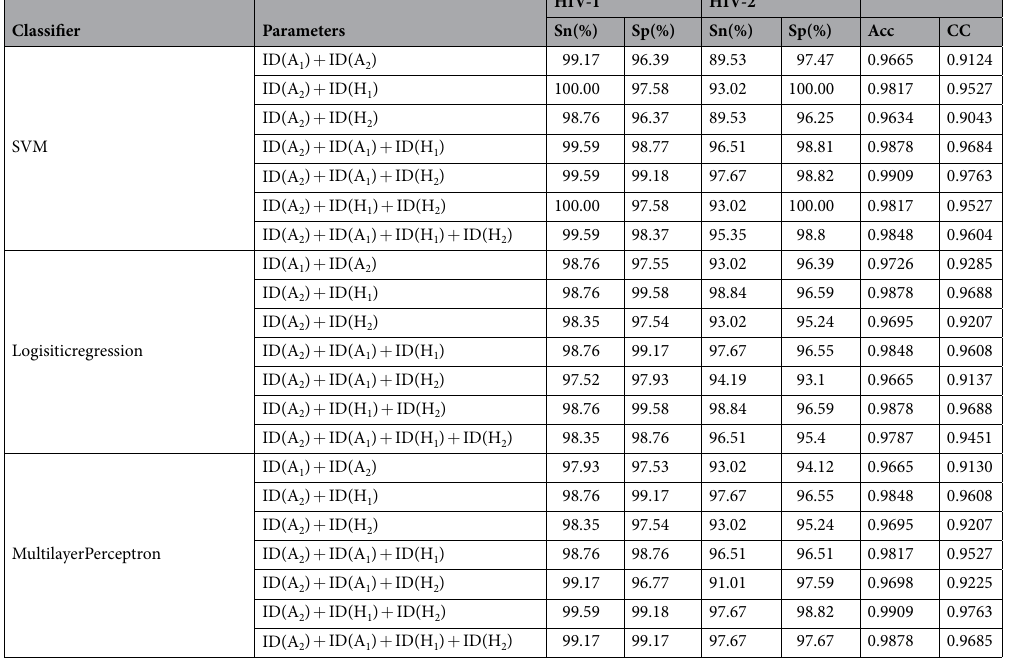
Table 3. The performance of different classifiers for prediction of HIV-1 proteins and HIV-2 proteins. (A 1 : amino acid composition;